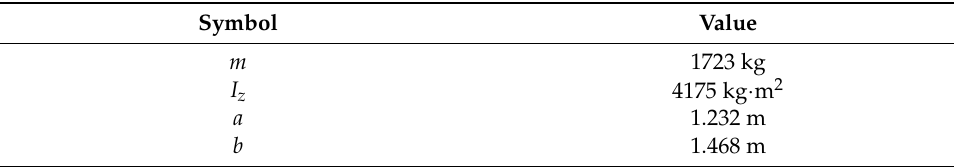
Table 2. Parameters of the vehicle model.